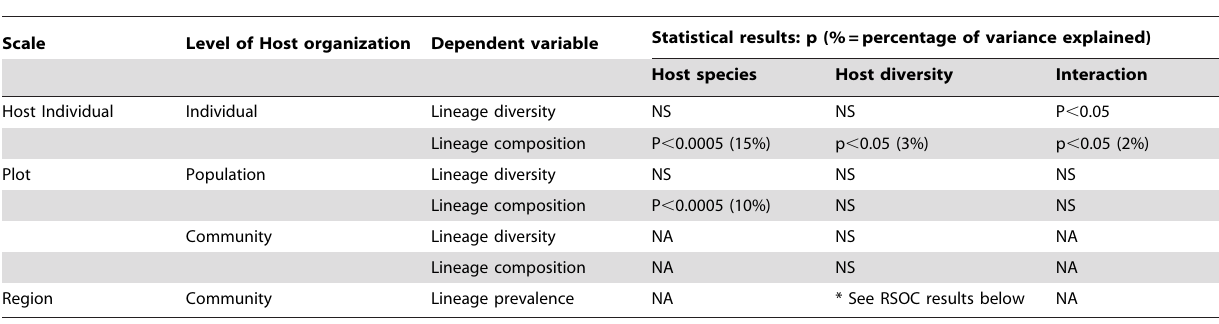
Table 2. Statistical results testing the effects of host species, host diversity and their interaction on diversity measures of bacterial communities of individual rodents, rodent populations, and rodent